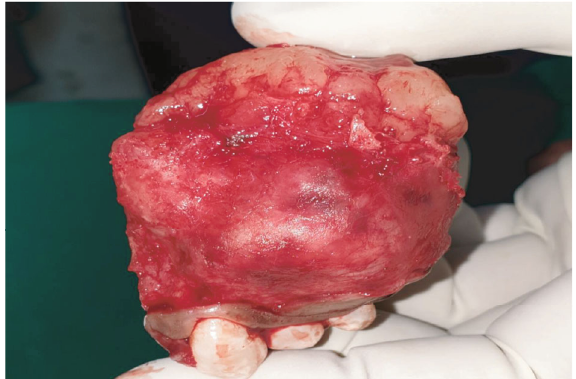
Figure 2: Excised